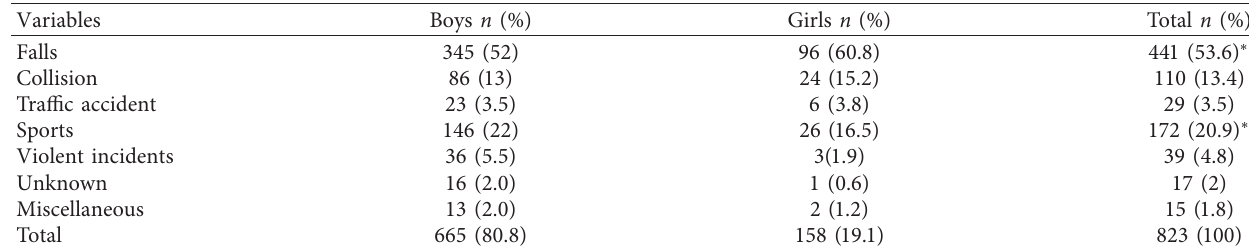
Table 3: Causes of traumatic dental injuries according to